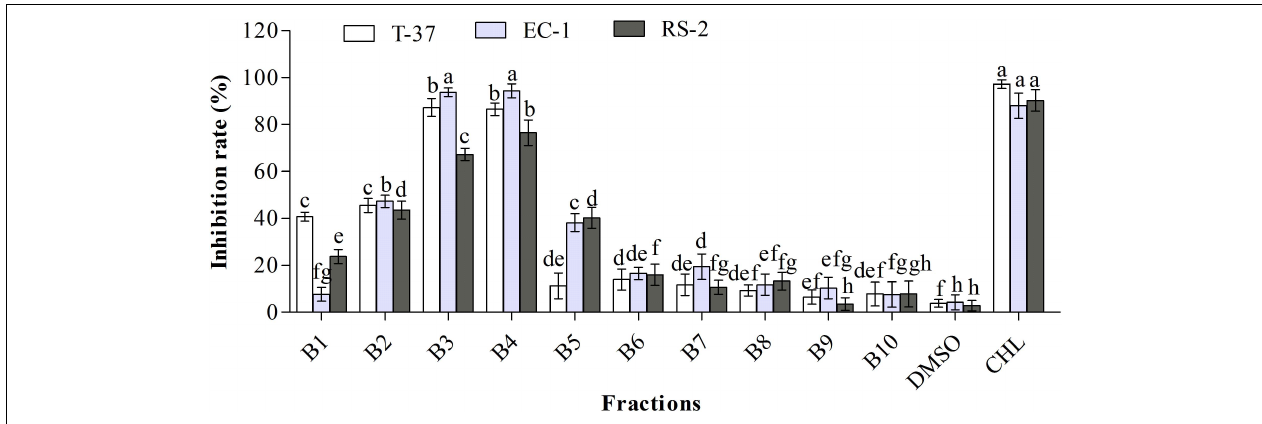
FIGURE 2 | Antibacterial activities of the sub-fractions of the ethyl acetate extract against the test bacteria. T-37, EC-1, and RS-2 represent Agrobacterium tumefaciens T-37, Erwinia carotovora EC-1, and Ralstonia solanacearum RS-2, respectively. DMSO represents dimethyl sulfoxide. CHL represents chloramphenicol. Different lowercase letters indicate significant differences ( P <